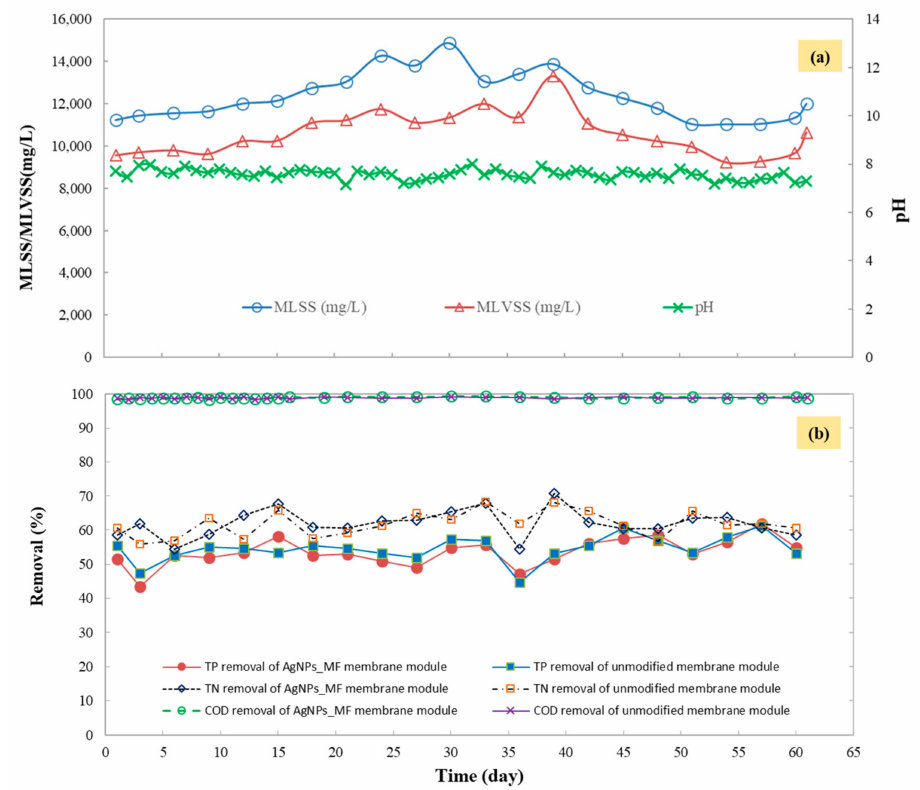
Figure 3. MF-MBR performance in terms of: ( a ) Operation condition, ( b ) removal of Chemical Oxygen Demand (COD), total nitrogen (TN) and TP of unmodified membrane module and the AgNPs-MF membrane module. The dissolved oxygen and temperature of the bioreactor were maintained in the range of 3 − 4 MgO 2 / L and 25–30 ◦ C,